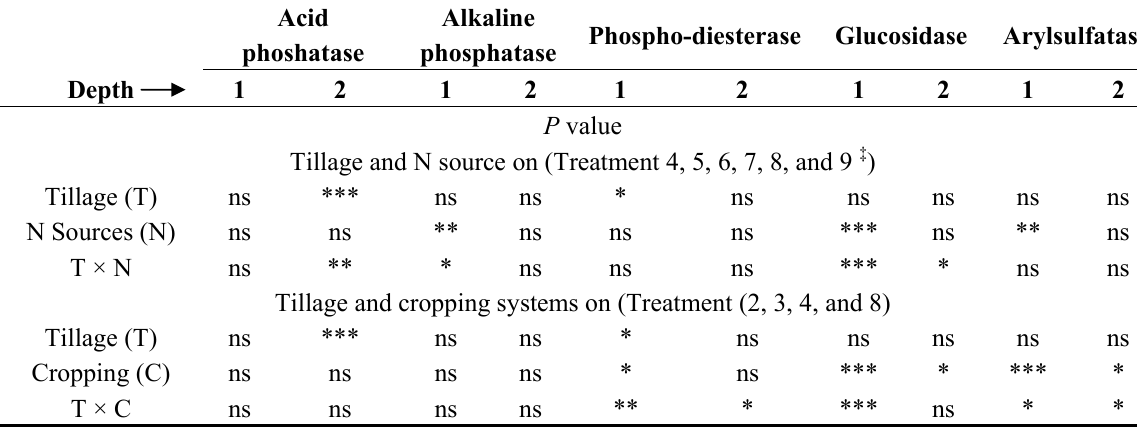
Tillage and cropping systems on (Treatment (2, 3, 4, and